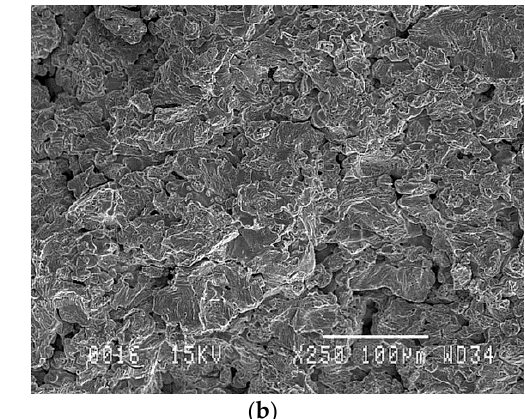
Figure 9. Profile roughness parameters for admixed and pre-alloyed at four R -ratios.